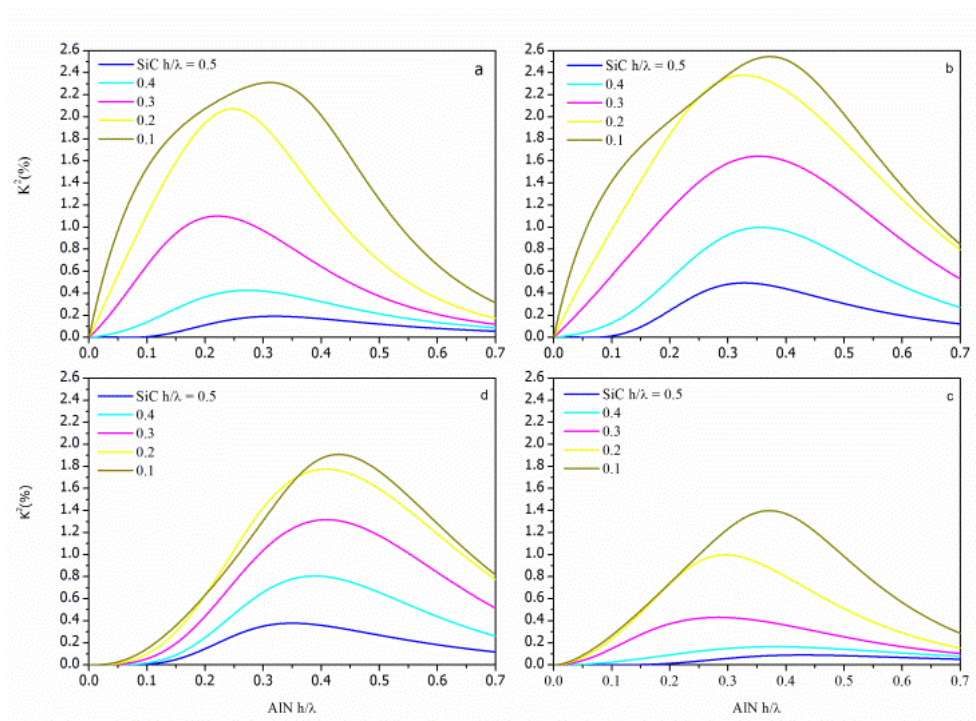
Figure 5. The K 2 dispersion curves of the ( a ) SMFT, ( b ) STFM, ( c ) SFT, and ( d ) STF coupling configurations on c-AlN/SiC(001)<110> substrates; the h/ λ the running